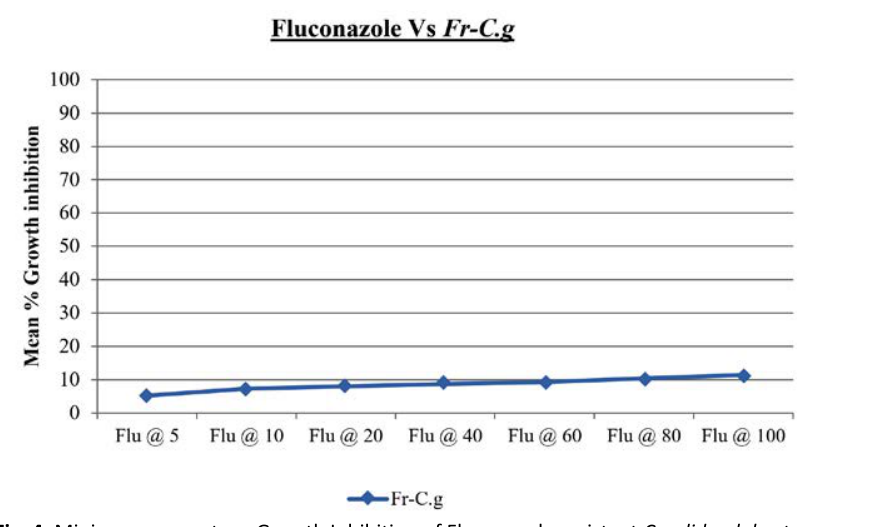
Fig. 3. Minimum percentage Growth Inhibition of Voriconazole resistant Aspergillus niger